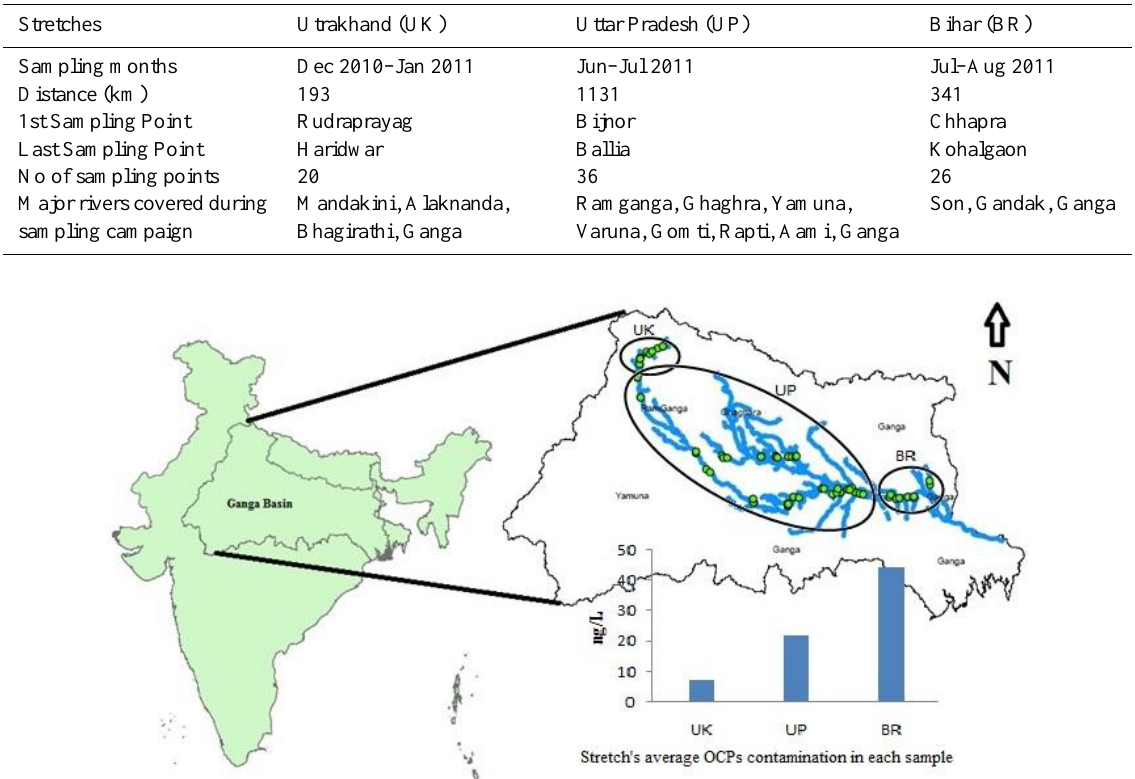
Figure 1: Sampling location of the river Ganga